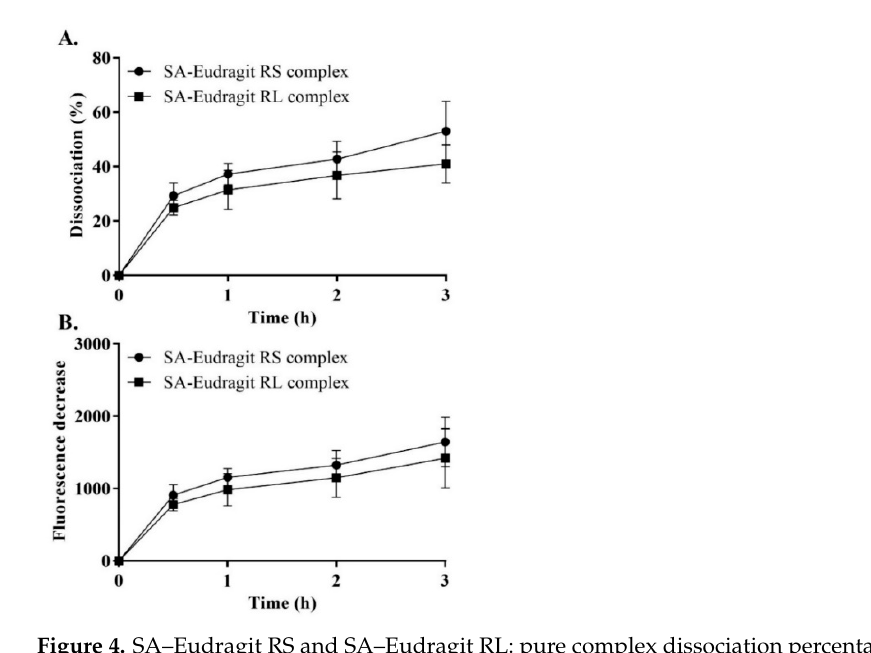
Figure 4. SA–Eudragit RS and SA–Eudragit RL: pure complex dissociation percentage ( A ) and the corresponding fluorescence decrease ( B ) in 1 mM phosphate buffer (pH 6.8) following dilution in a quantifying medium of 0.1 mM phosphate buffer (pH 6.8) containing 0.001% fluorescein at a 1 h time interval for a duration of 3 h. Indicated values are the means ± SD ( n ≥ 3).